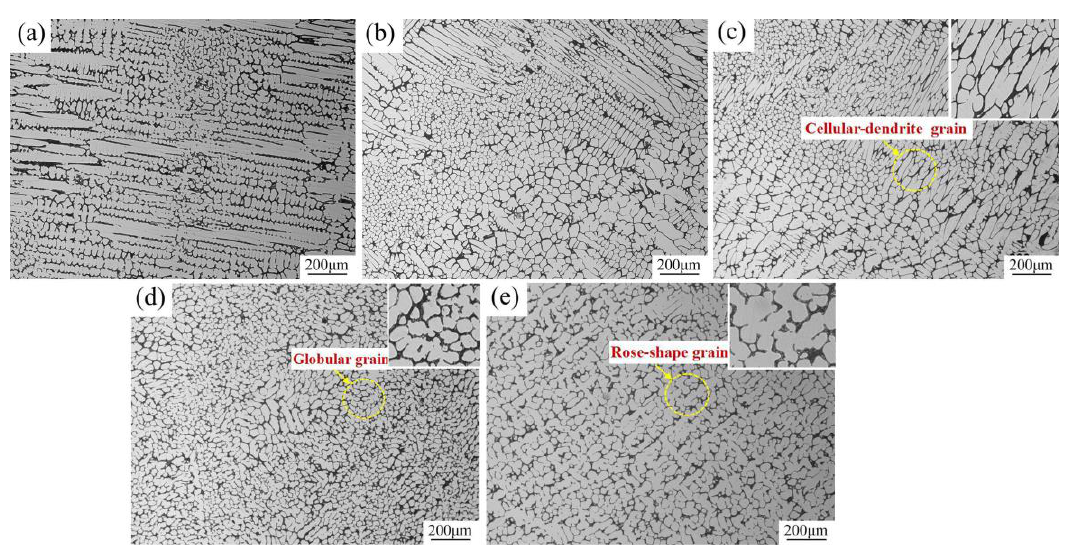
Figure 1. Effect of various isothermal treatment temperatures on the microstructure of Ni-Cr-W superalloy: ( a ) 1480 °C; ( b ) 1420 °C; ( c ) 1410 °C; ( d ) 1400 °C; ( e ) 1390 °C.